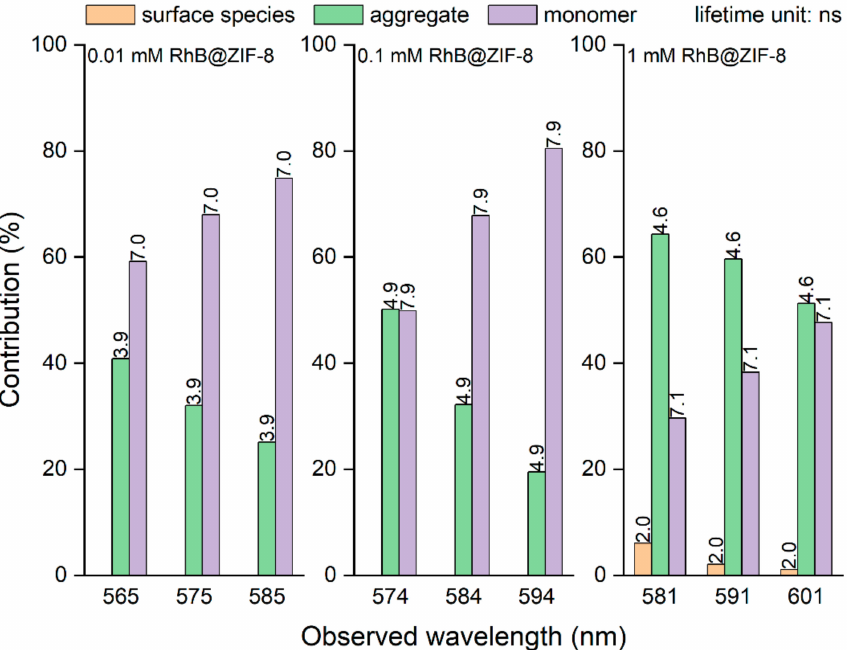
Figure 3. mM RhB@ZIF-8 material presents it as a natural candidate for applications where energy ef- ficiency is crucial (Tables S2 and S3). We therefore explore the applicability of the 0.01 mM RhB@ZIF-8 material as a WLED component phosphor in the next